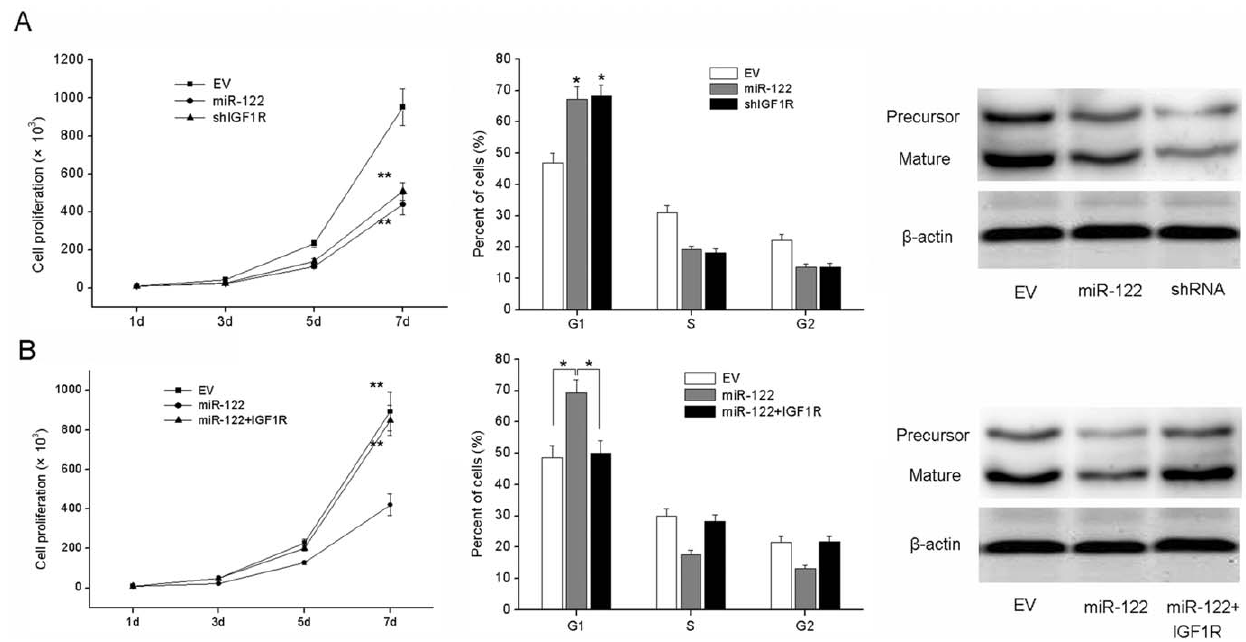
Figure 4. IGF1R is involved in miR-122-induced growth inhibition in BC cells. (A) MCF-7 cells were infected with Lv-shIGF1R or Lv-miR122. Cell growth rate and cell-cycle distribution were measured. (B) MCF-7 cells were infected with LV-miR122 for 72 hours, followed by infection with LV- IGF1R, and cell proliferation and cell-cycle analysis were then performed. *P , 0.05 compared to EV group or comparison between 2 groups as indicated, **P , 0.01 compared to EV group or comparison between 2 groups as indicated.